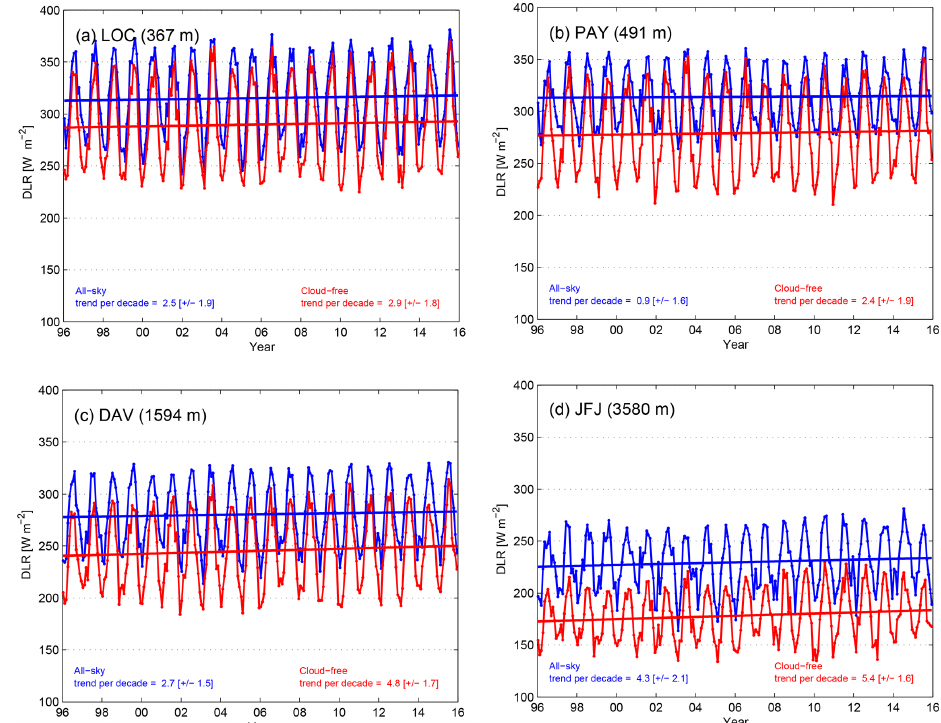
Figure 1. Monthly average DLR values during all-sky (blue) and cloud-free (red) conditions at (a) Locarno, (b) Payerne, (c) Davos, and (d) Jungfraujoch. Each panel shows trend results from linear least-squares analysis in Table 3. Values in square brackets represent the 90% confidence interval of the trend. Scales are similar to aid the